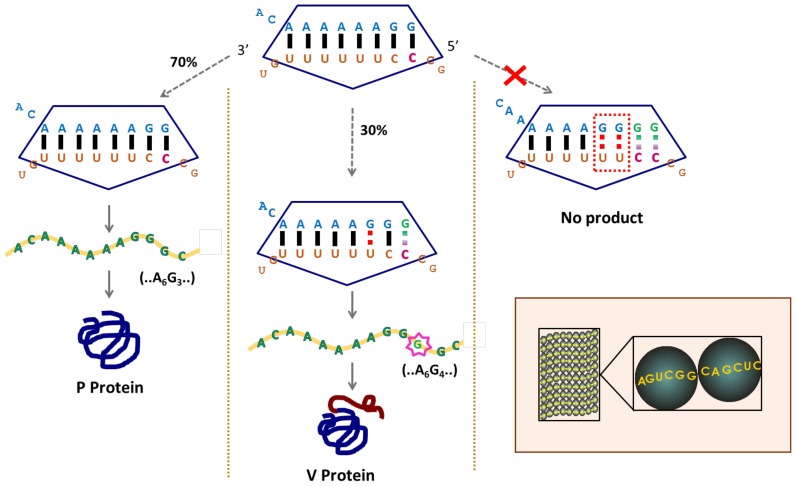
Programmed transcriptional frameshifting in members of the Paramyxovirinae. In the P-gene mRNA of Sendai virus, the insertion of a G occurs over the minus strand template RNA slippery sequence UUUUUUCCC. In 30% of the population (middle panel), a pause in RdRp over the slippery sequence promotes slippage of a G-C bond to form G:U pairs (in red dotted lines). Polymerization resumes by addition of a G (in green) over the critical C (in pink), thus encoding mRNA for the V-protein in an overlapping translational −1 frame compared to genomic template. The panel to the right shows that the potential insertion of two G's has very poor likelihood due to multiple G-U pairs not being tolerated. Inset: Hexamer phasing in members of the Paramyxovirinae. The ribonucleoprotein (RNP) structure is a left-handed coil where each nucleocapsid protein binds precisely 6 nucleotides.